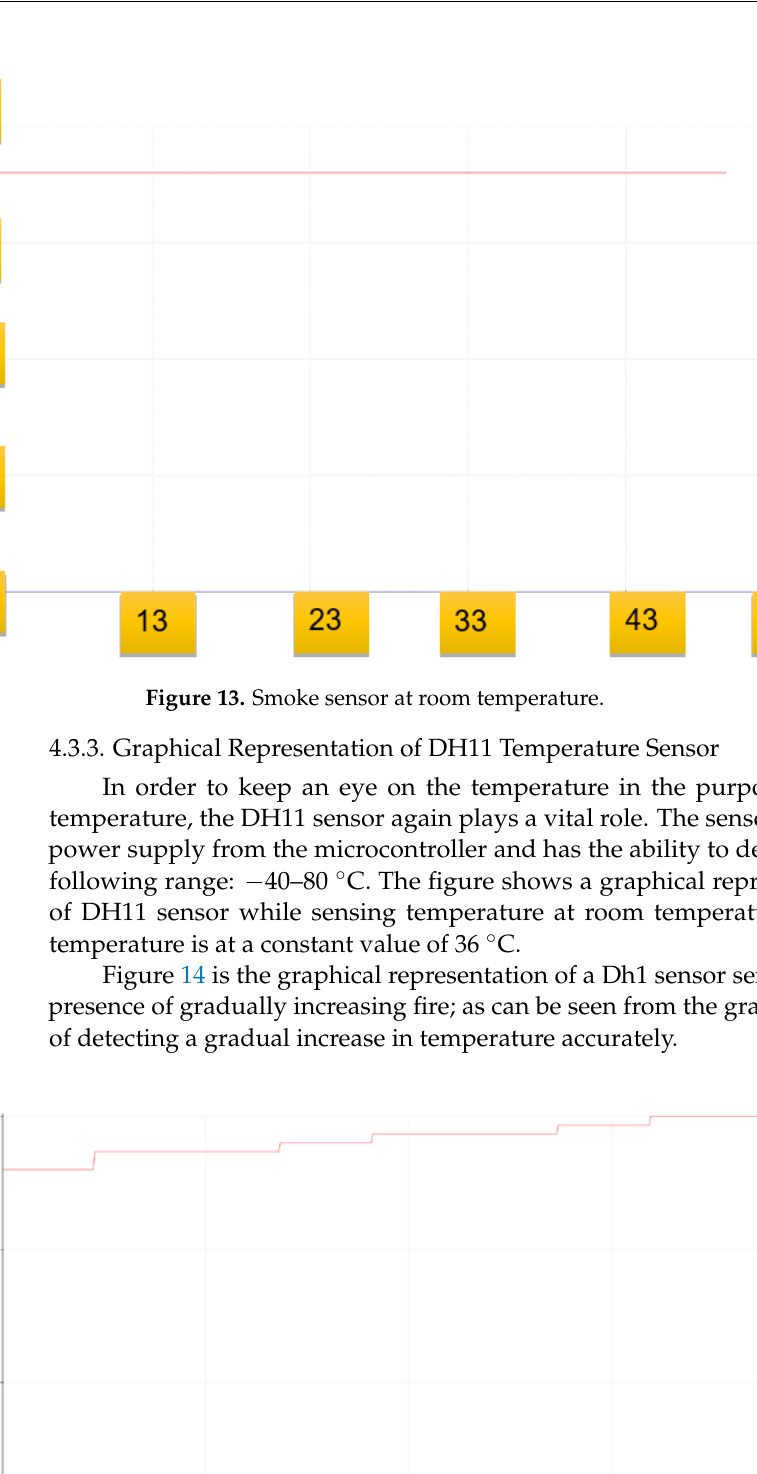
Figure 12. Humidity sensor in the presence of flame.